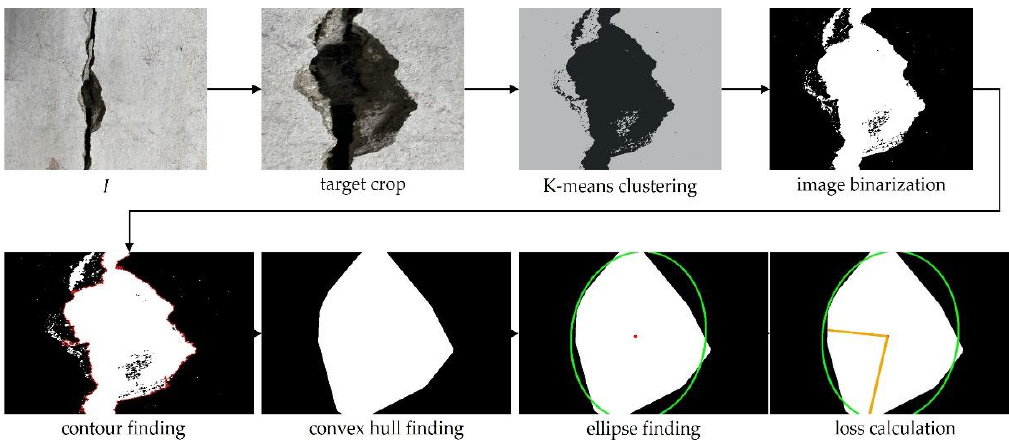
Figure 13. Structure of the 𝐿𝑜𝑠𝑠 𝑠𝑝𝑎 computation.